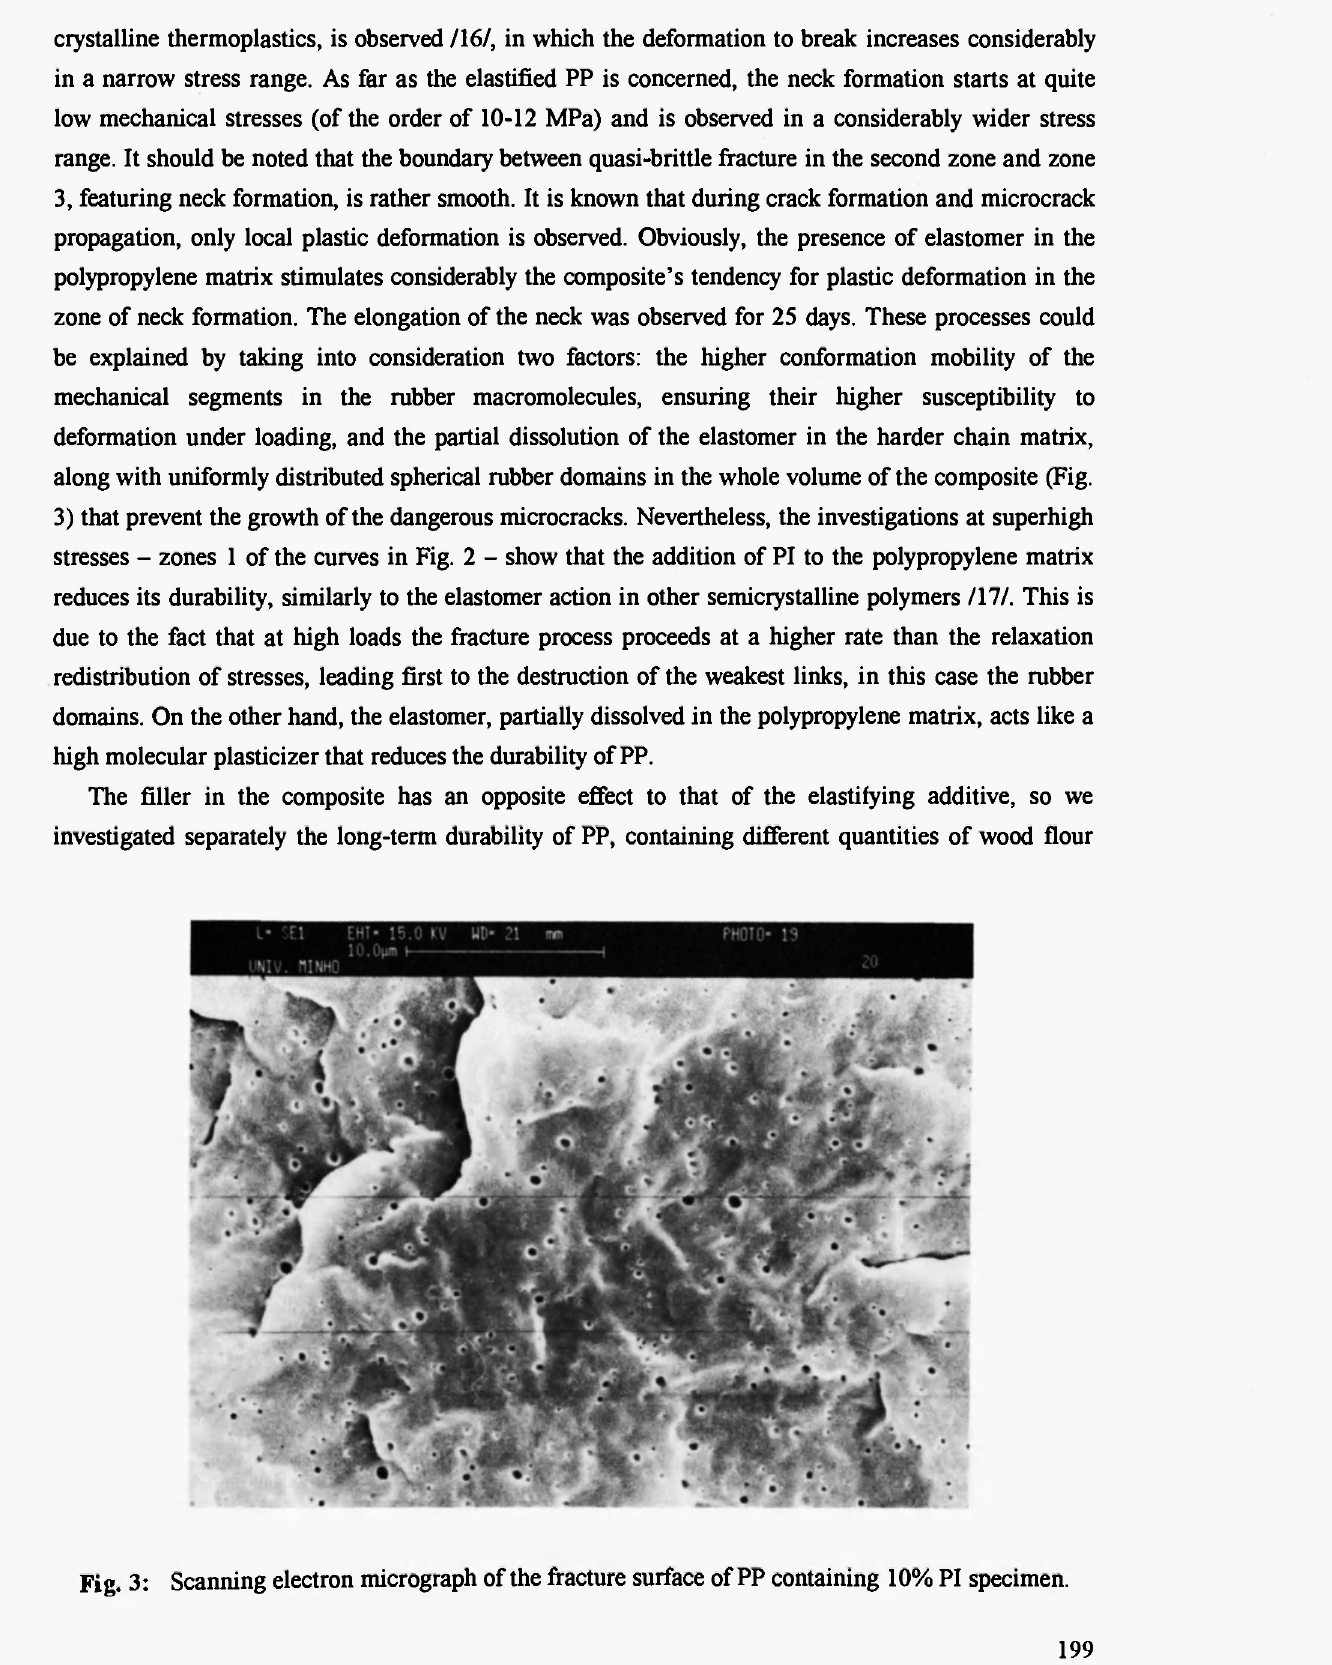
Fig. 3: Scanning electron micrograph of the fracture surface of PP containing 10% PI